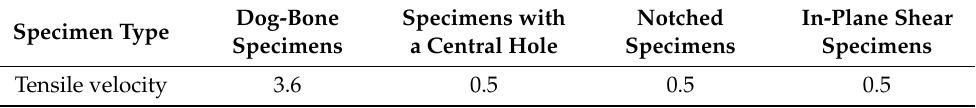
Table 2. The applied tensile velocities for different specimens (mm/min).